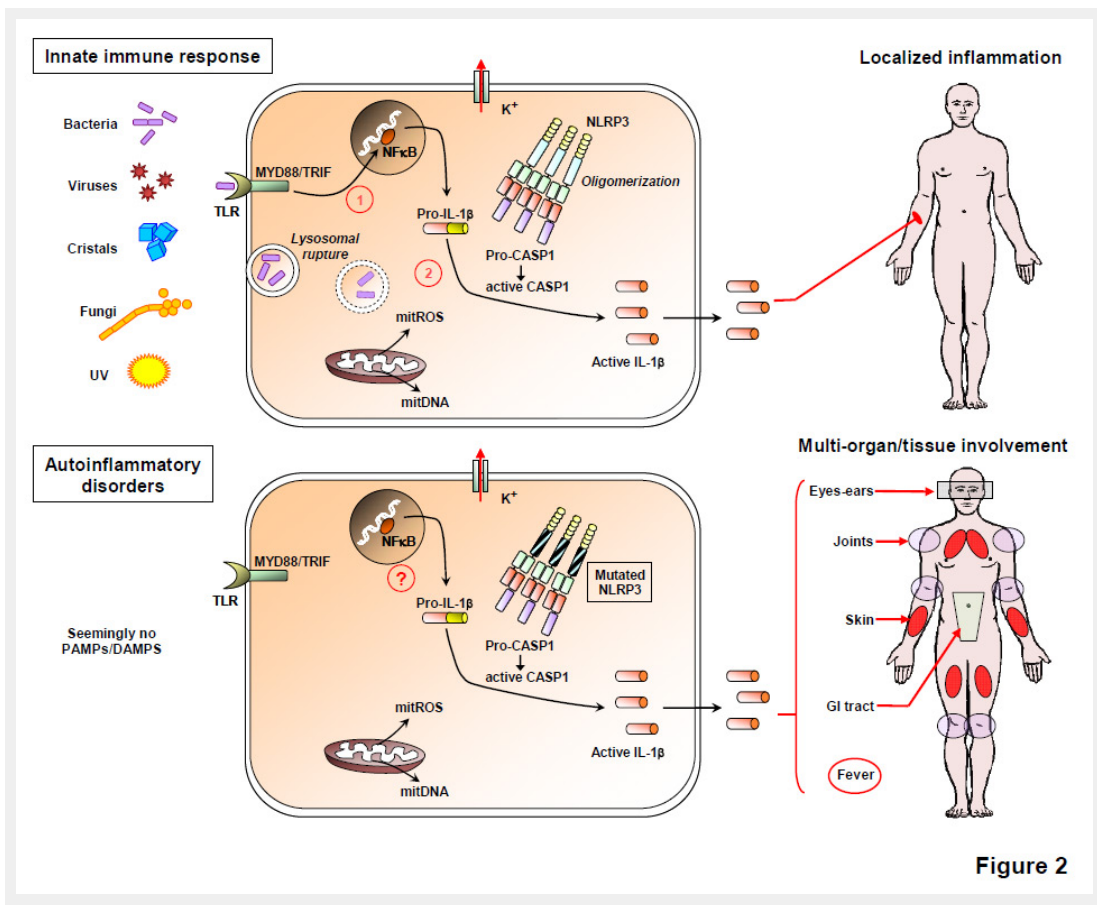
Figure 2 Current models of inflammasome activation involve K + efflux, release of reactive oxygen species (ROS) and mitochondrial DNA (mtDNA) in the cytosol. Upon encounter of PAMPs/DAMPs including microbes or crystals, the NLRP3–inflammasome is activated and the resulting IL-1β release triggers localised inflammatory responses. In contrast, the NLRP3–inflammasome is constitutively activated, resulting in multi-organ involvement and periodic fever in patients suffering from autoinflammatory